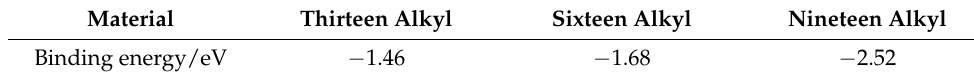
Table 2. The binding energy of different graft chain lengths.